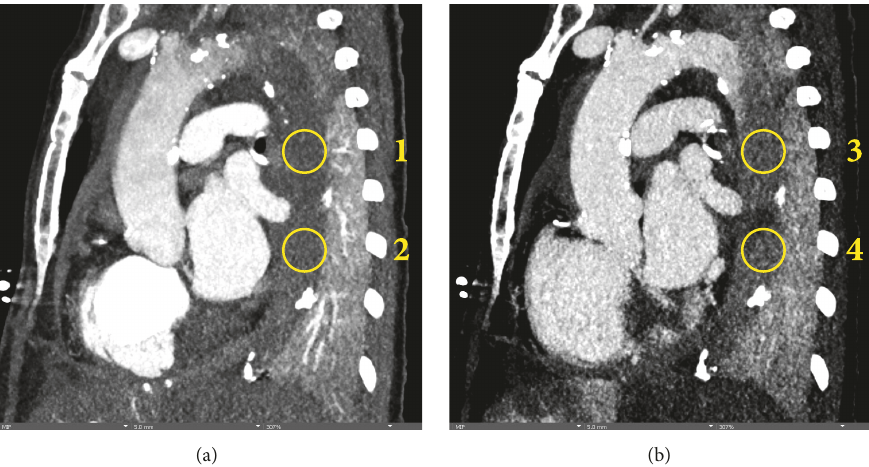
Figure 2: Acute aortic occlusion. Computed tomography. (a) Sagittal plane, arterial phase after intravenous injection of contrast agent. The descending aorta is not filled with contrast (circle 1: 70 HU, circle 2: 73 HU). Note the severe calcification of the aorta. (b) Sagittal plane, late phase after intravenous injection of contrast. While few contrast entersthe proximal part of the thrombus (apposition zone, circle 3: 105 HU), it does not reach the already more solid parts of the thrombus (circle 4: 78 HU). HU: Hounsfield